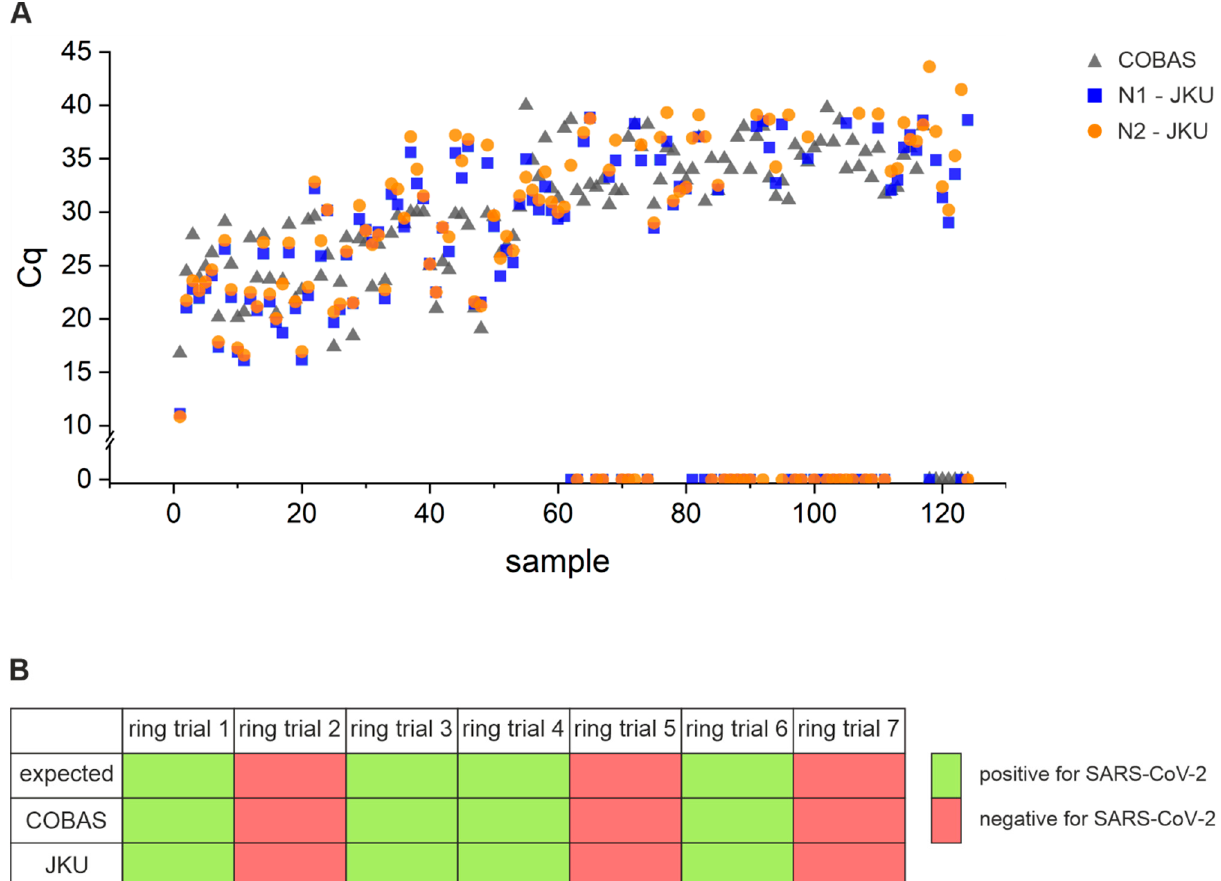
Figure 3. ( A ) 124 SARS-CoV-2 patient samples with an amplification measured either by the KUK with the Roche COBAS diagnostic test (COBAS) and/or our in-house platform for two different targets (N1-JKU and N2-JKU) are displayed with their respective Cq value. Marks on the x -axis represent samples without an amplification and are likely false negatives. ( B ) A ring trial was performed with seven samples containing different viral strains provided by the KUK. Samples were classified as positive (green) or negative (red) for SARS-CoV-2, and compared to the expected outcome, the results reported by the diagnostic COBAS system and our protocol (JKU). Note that we measured these samples in duplicates using the two different RT-qPCR kits (Luna and TaqMan) for each replicate.